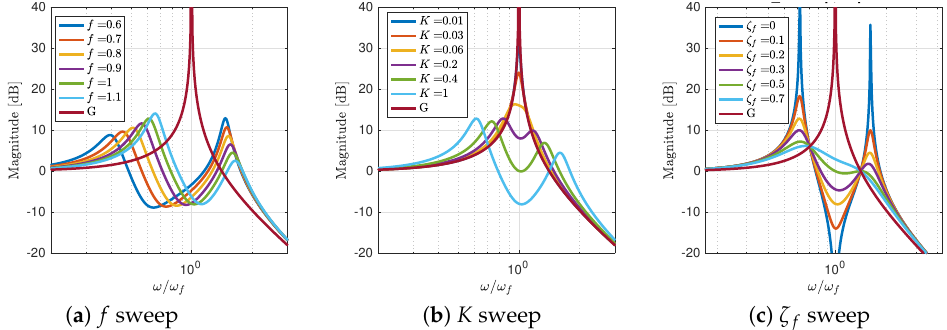
Figure A1. Influence of the tuning parameters on the closed-loop frequency response of a single-mode system with FracNPF with α =